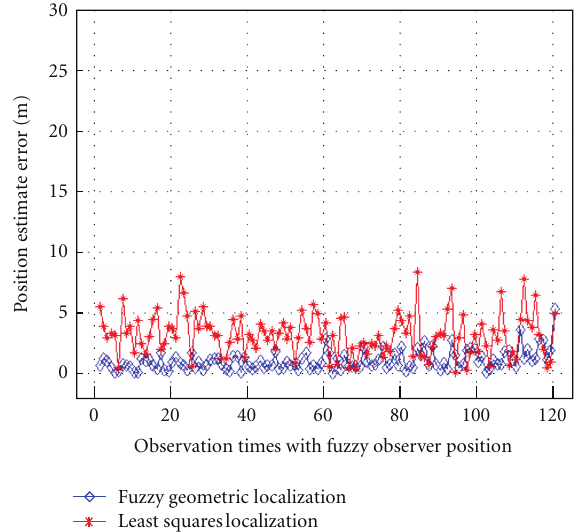
Figure 5: Position estimate error comparison with fuzzy observer positions.